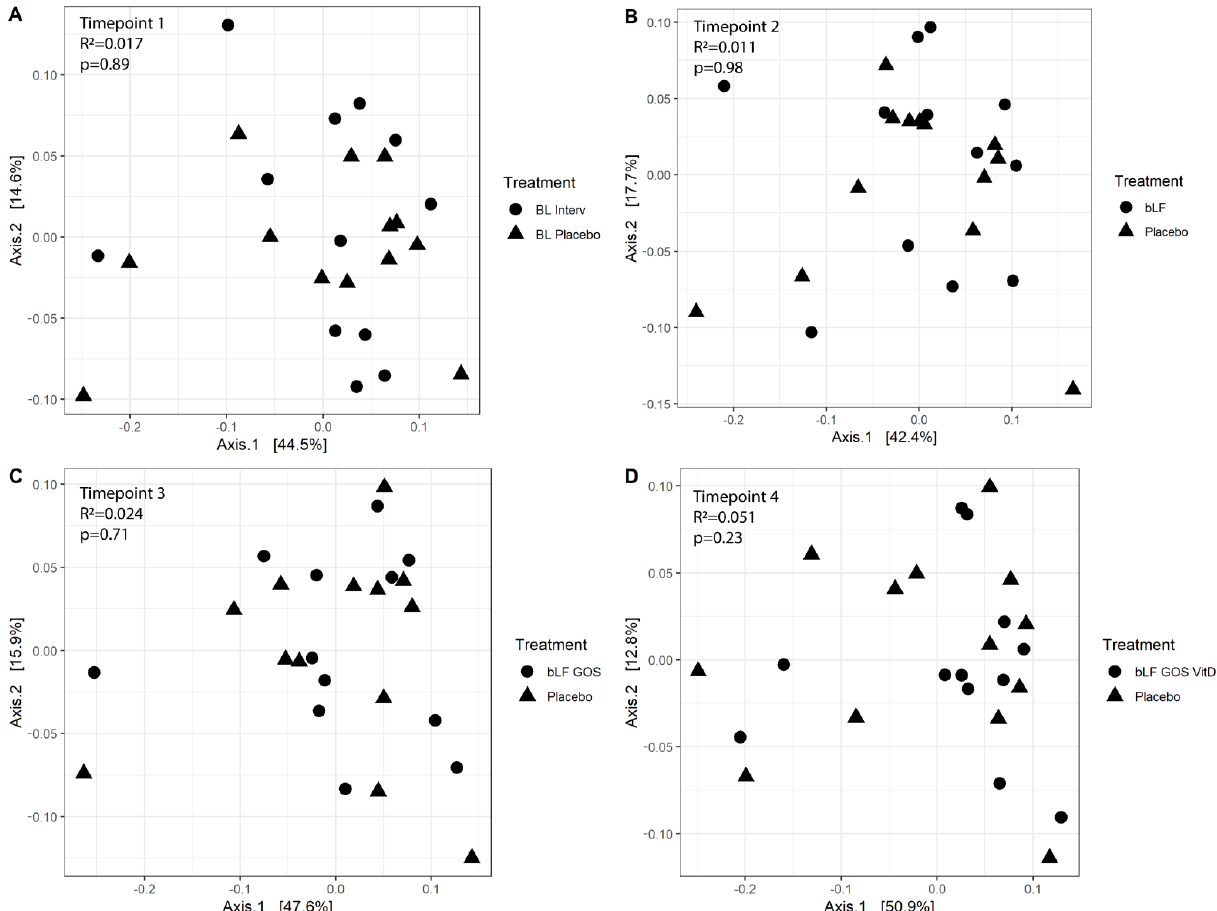
Figure 1. Principal coordinates analysis within each timepoint, based on weighted UniFrac distances. ( A ) At baseline between the intervention (BL Interv) and placebo (BL Placebo) group. ( B ) After 3 weeks, when the intervention group was receiving bovine lactoferrin (bLF). ( C ) After 6 weeks, when the intervention group was receiving bovine lactoferrin and galactoligosacharides (bLF GOS). ( D ) After 9 weeks, when the intervention group was receiving bovine lactoferrin, galactoligosacharides and vitamin D (bLF GOS VitD). No differences were observed between the two groups as determined by ADONIS analysis of variance with significance set at p < 0.05. Shapes represent the treatment each subject received at the respective timepoint. Percentages at the axes indicate the fraction of observed variation explained.